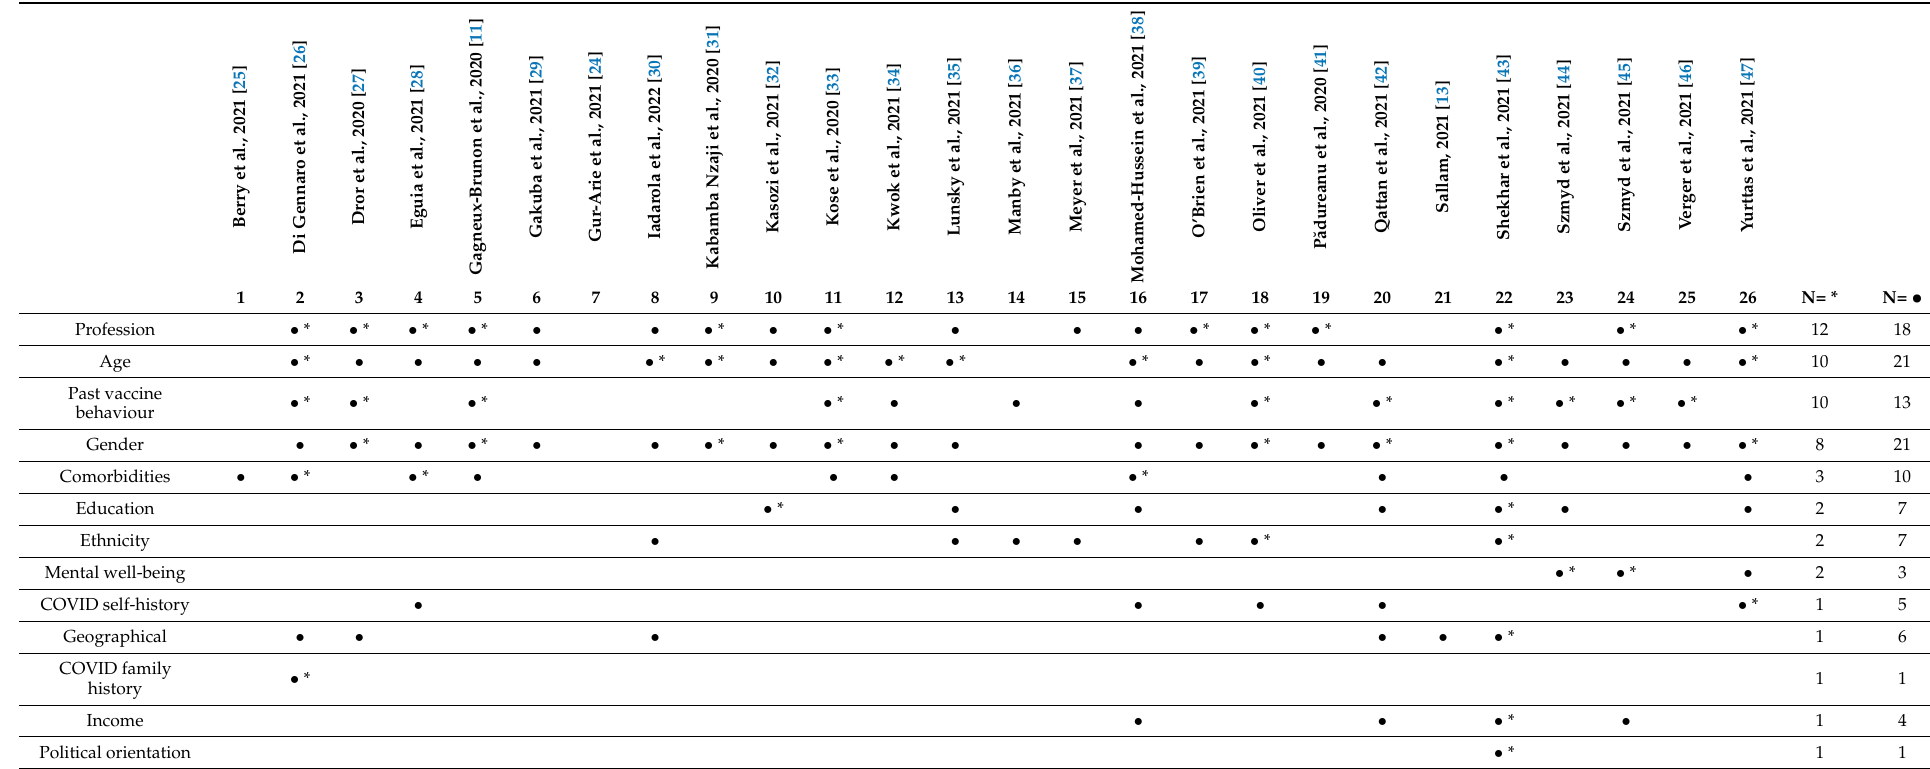
Table 2. Socio-demographical predictors of vaccine